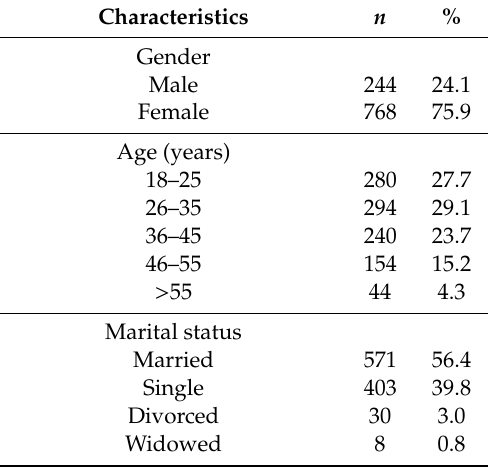
Table 1. Demographic characteristics of study participants ( n =